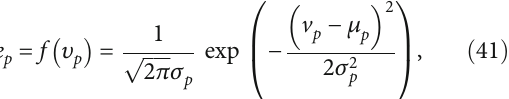
Table 4: Control parameters and nominal